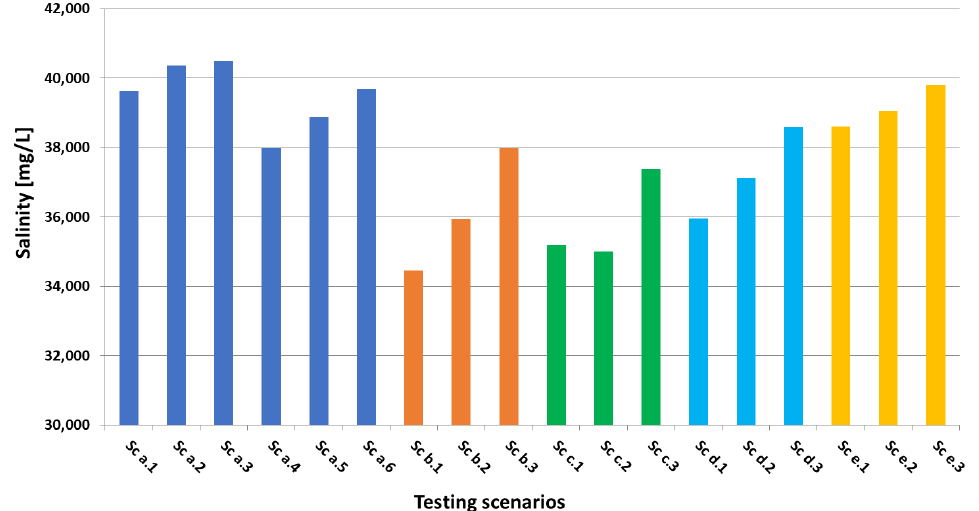
Figure 13. Predicted maximum salinity after 50 years for 18 scenarios.